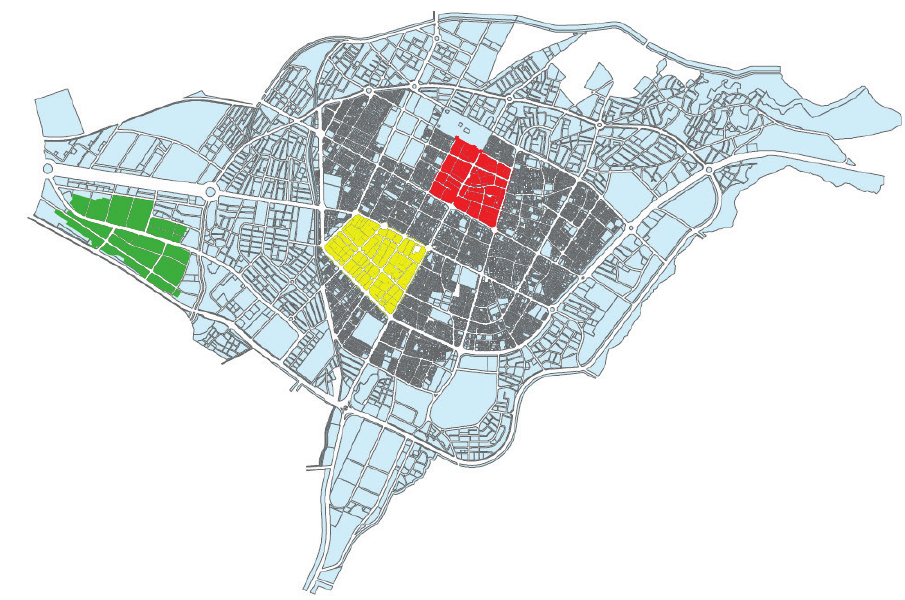
Figure 4. Introducing the studied districts (source: authors)